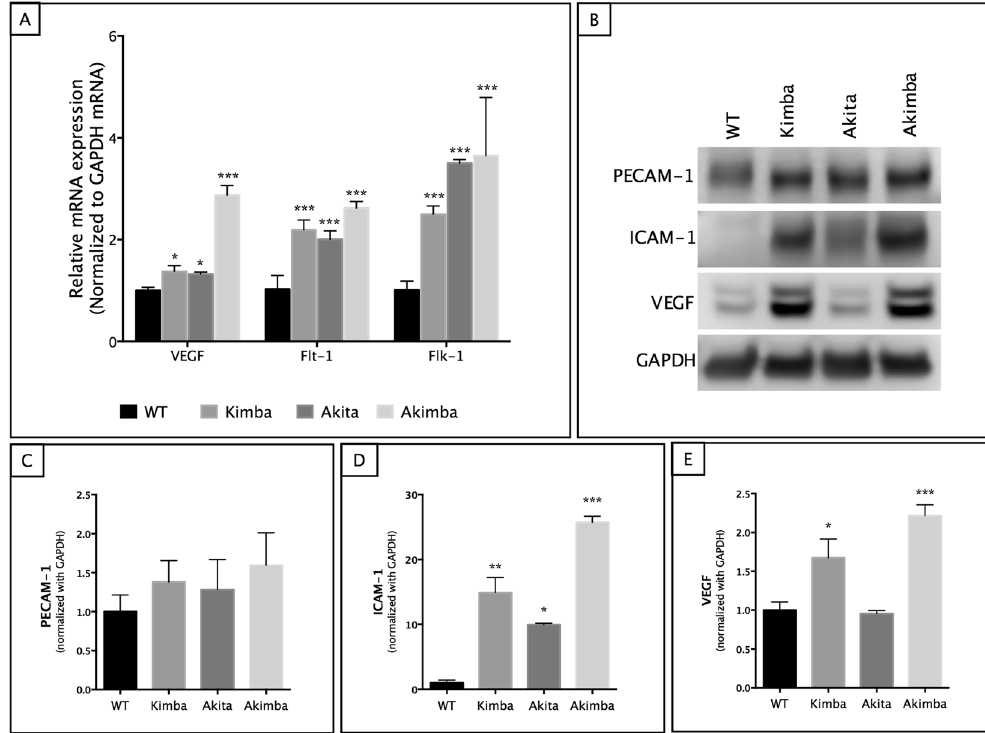
Figure 8. Pro-angiogenic factors were upregulated in Akimba retina. mRNA expression of VEGF showed a 3-fold increase in Akimba mouse ( A ), corresponding with a > 2-fold increase in protein expression seen in Western blot ( B , E ). Similarly, ICAM-1 was elevated ( B , D ) up to 15-fold in Kimba and 25-fold in Akimba mice. PECAM-1 showed an upward trend but was not statistically significant in any of the mouse models studied ( B , C ). n = 4 retina per group for qPCR and western blot; repeated twice. * p < 0.05; ** p < 0.01 and *** p < 0.001 compared to WT. Data represent mean ±